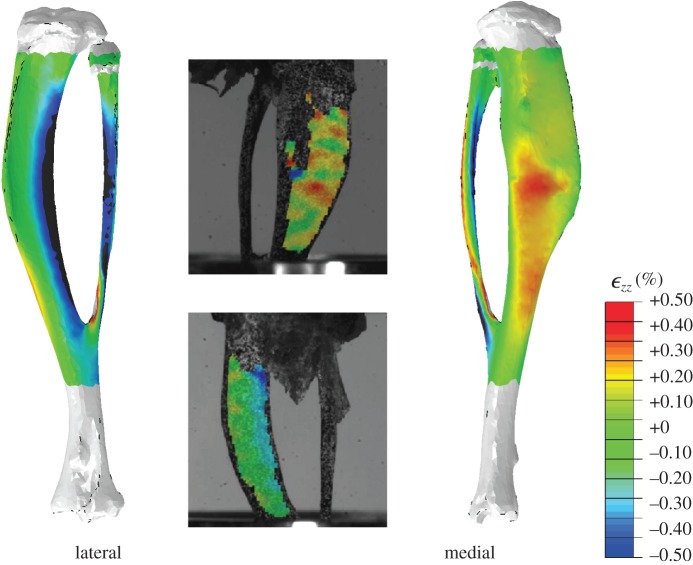
Contour plots of the longitudinal strains  calculated in the FE models and DIC measurements in eight-week-old mice of the same strain and gender by Sztefek et al. [34]. FEA used the geometry of a non-adapted tibia under an axial peak load of 12 N. (DIC images adapted from [34] with permission from Elsevier.)